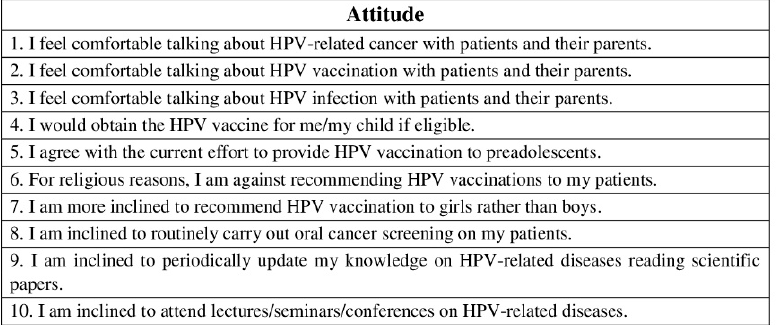
Figure 4. Questionnaire assessing pediatric dentists’ perceptions on HPV-related OP-cancer, HPV infection, and HPV vaccine. Level of agreement to each statement was assessed by a five-point Likert scale: 1. strongly disagree; 2. disagree; 3. neither agree nor disagree; 4. agree; 5. strongly agree.